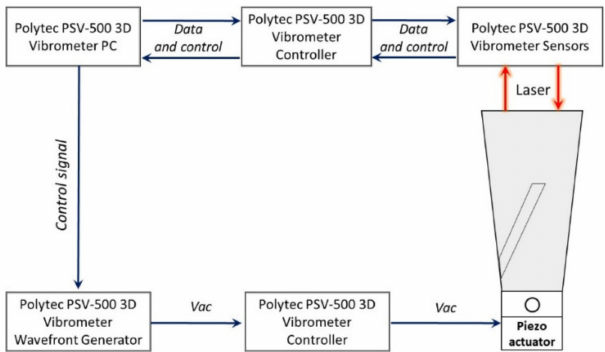
Figure 10. Vibrational response test setup used for tool holder with and without helical slots. (1)— Positioning of the tool holder with and without helical slots during the experiment.